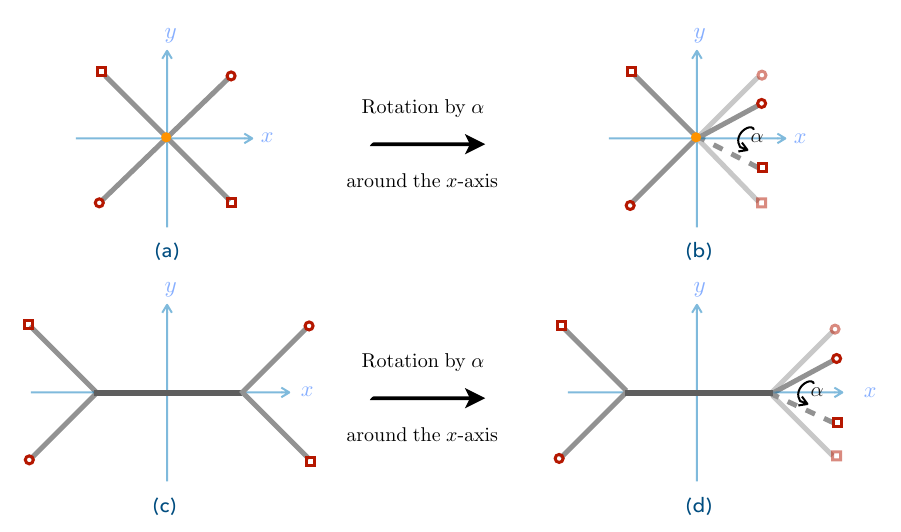
Figure 2 . The supersymmetry breaking deformation of the E 1 theory at infinite (above) and finite (below) coupling. At infinite coupling the (1 , 1) strings stretched between the two (half) (1 , 1) 5-branes develop a tachyonic mode. At finite coupling the four-brane junction split and the strings get stretched and have a minimal distance of order h . This provides a positive mass squared contribution which competes with the tachyonic